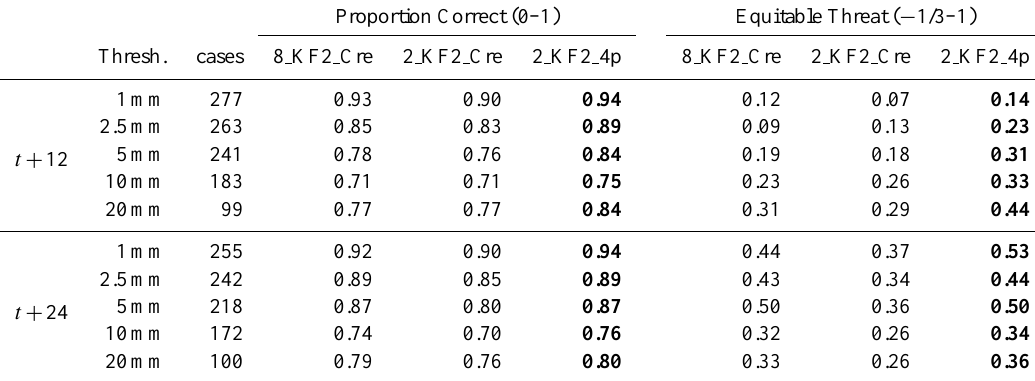
Table 2. As in Table 1, but for Proportion Correct (PC) and Equitable Threat (ET) scores, for 5 precipitation thresholds. The best values are presented in bold.